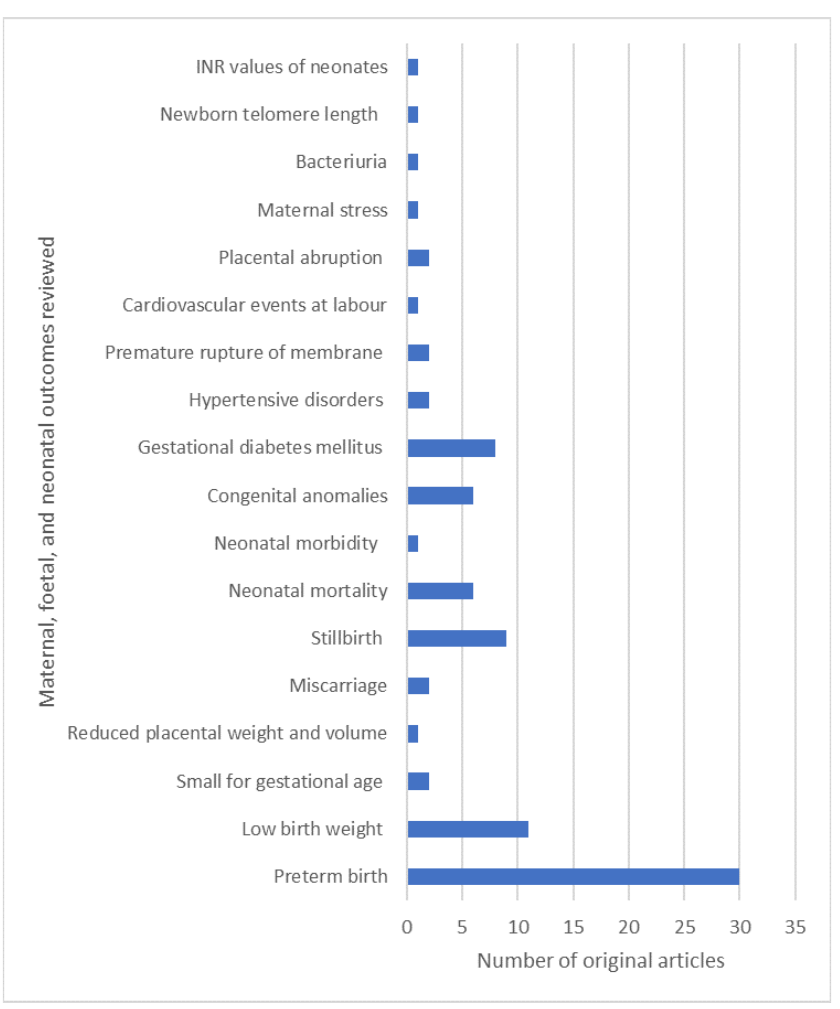
Figure 3. Maternal, foetal, and neonatal outcomes examined in this review. Note: Some studies examined multiple outcomes.